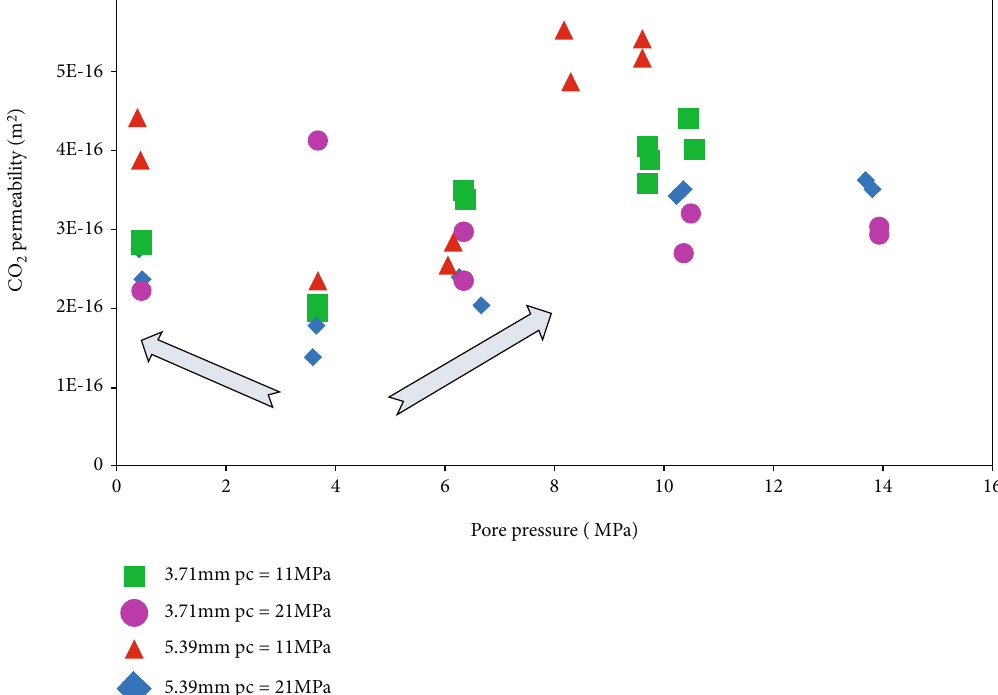
injection test with the con fi ning (hydrostatic) pressure at 11MPa. 2